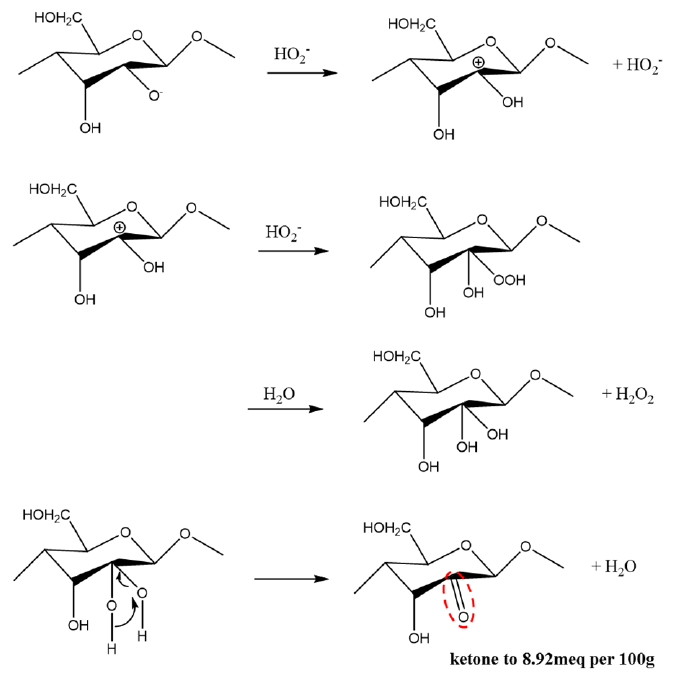
Figure 7. Oxidation of cellulose by hydroperoxyl radicals.